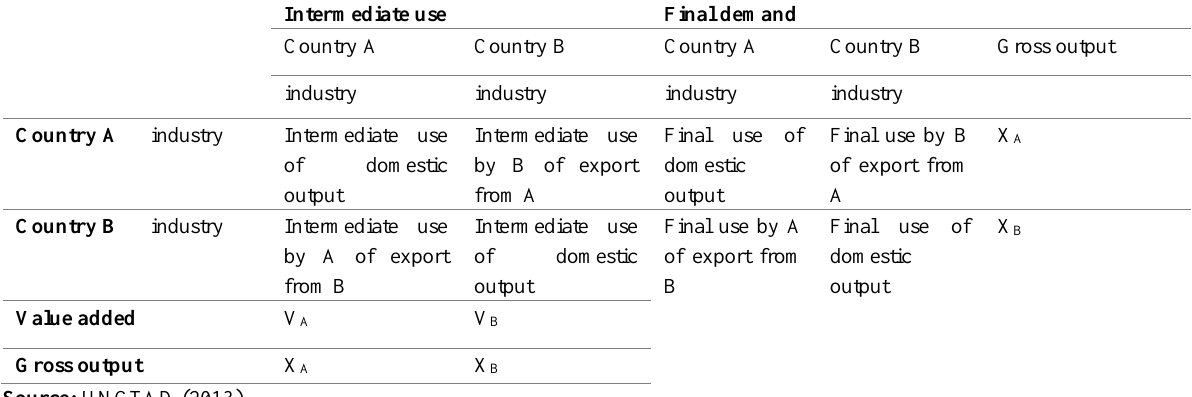
Table 1: Framework of GVC flows